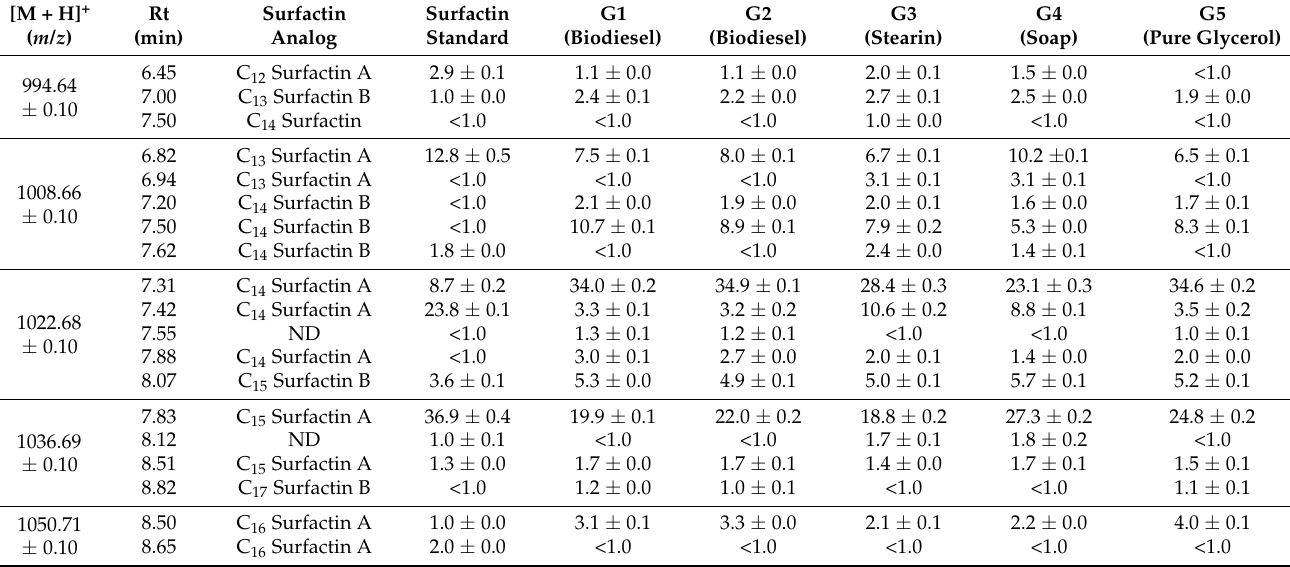
Table 2. Relative abundance (%) of surfactin structural analogs present in surfactin standard (Merck) and in the cultures of Bacillus subtilis #309 grown in mineral salt medium (MSM) supplemented with glycerol from different sources (G1, G2, G3, G4 or G5). Analogs with a relative abundance >1% were quantified. The results are presented as mean ± standard deviation. MS/MS spectra of surfactin variants, together with the elucidation of their structures, are shown in Supplementary Materials. Rt: retention time. ND: no